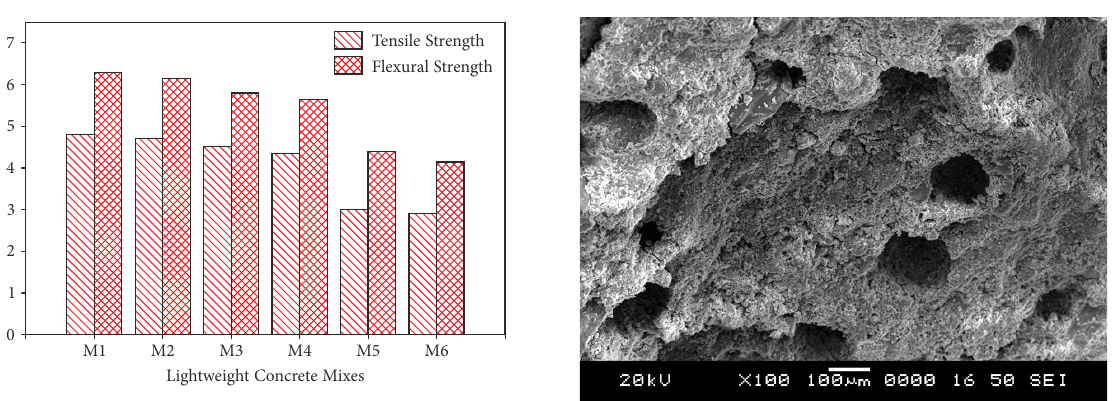
Fig. 5. Tensile and Flexural Strengths of Lightweight Concrete Mixes at the age of 28 days Fig. 6. SEM micrograph (secondary electron image) showing voids entrapped within the lightweight concrete